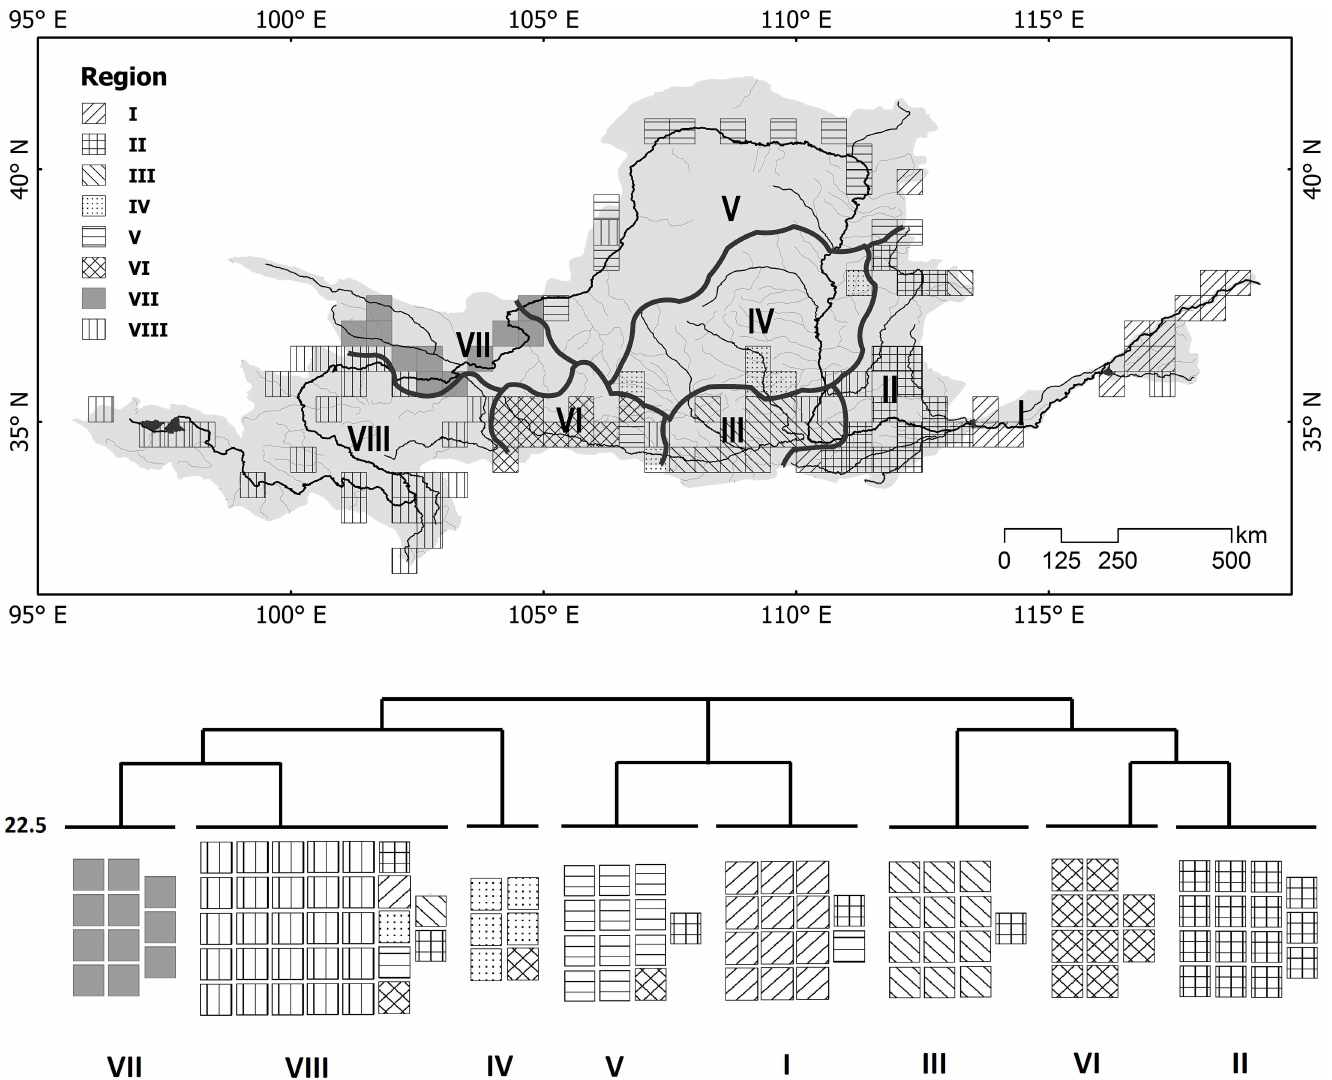
Fig 2. Map of the freshwater fish biogeography in the Yellow River, as well as the clustering tree. The entire basin was groupedinto 8 divisions, including Region I, Estuary. The fish here are riverinespecies. RegionII, Lower Yellow. Speciesfrom Gobio , Danioninaeand Leuciscinae are the main fauna here. Region III, Lower Wei. The dominant species are from Danioninae, Leuciscinae, and Triplophysa . Region IV, Middle Yellow.Few specieslive in this arid area, and nearly all are from Danioninae. RegionV, Upper Yellow.Fish from Cultrinae,Rhinogobio,Cobitinaeand Siluridaeare the dominant fauna here. Region VI, Upper Wei. Fish fauna here are dominated by Platypharodon and Triplophysa . RegionVII, Huangshui.The fish here are almost entirelySchizothoracinae, Triplophysa , and Leuciscinae. RegionVIII, Source. The fish here are all from Schizothoracinae and Triplophysa .